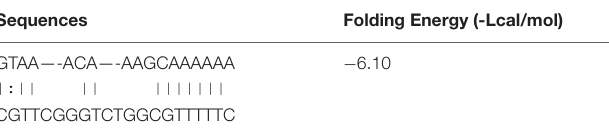
TABLE 1 | Bonding sequence of miR-129-5p to Tcf4 -3 (cid:48)